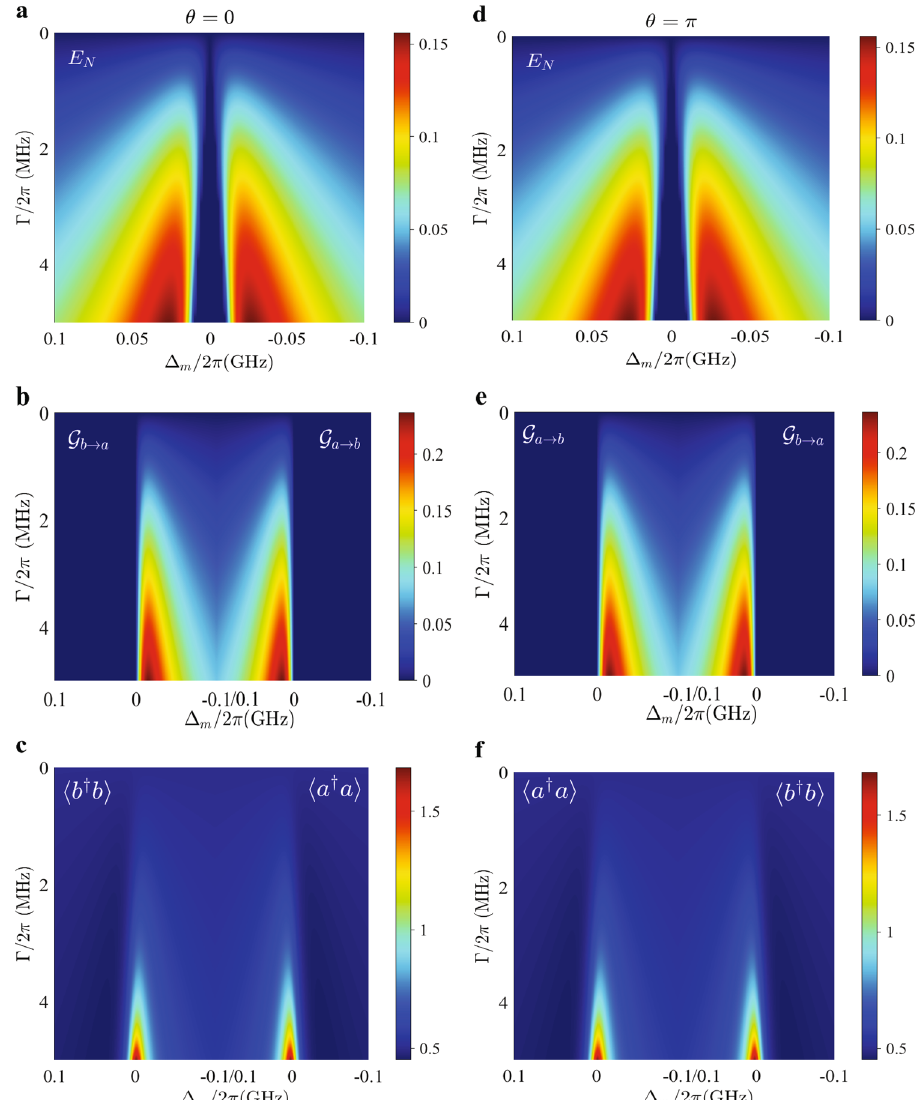
Fig. 3 Quantum correlations results. a , b Entanglement E N , b , e steering ( G b ! a and G a ! b ), c , f population of modes ( 〈 b † b 〉 and 〈 a † a 〉 ) versus Γ for a – c θ = 0 and d – f θ = π , where J /2 π = 5 MHz, the other parameters are the same as those in Fig. Δ m and